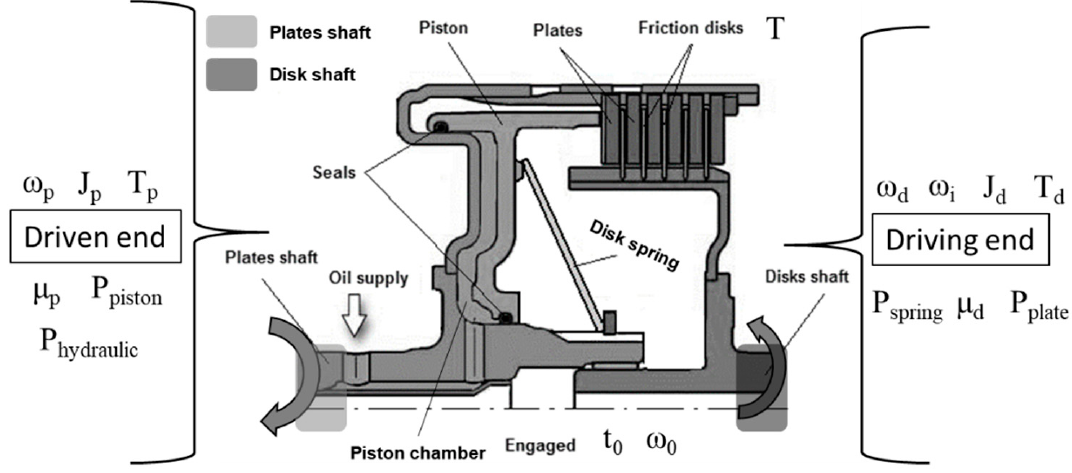
Figure 3. The cross-sectional view of the clutch pack for the PST.